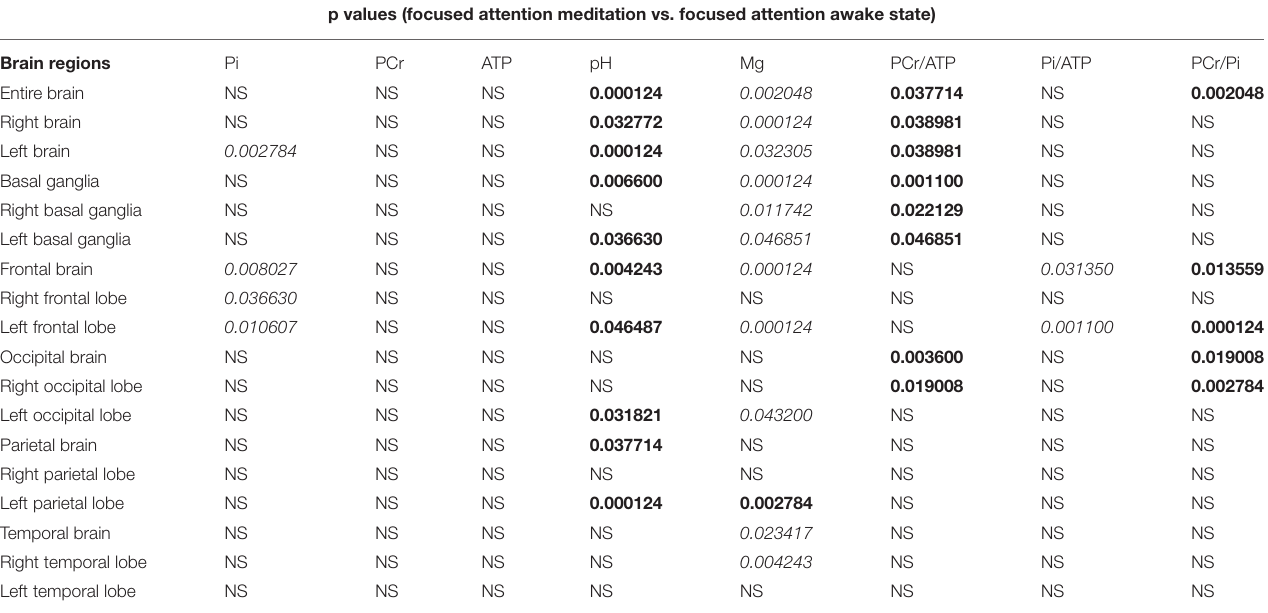
TABLE 1 | Phosphorous magnetic resonance spectroscopy ( 31 PMRS) results: P -values after correction were given for areas with significant difference between focused attention meditation (FAM) and focused attention awake state. p values (focused attention meditation vs. focused attention awake